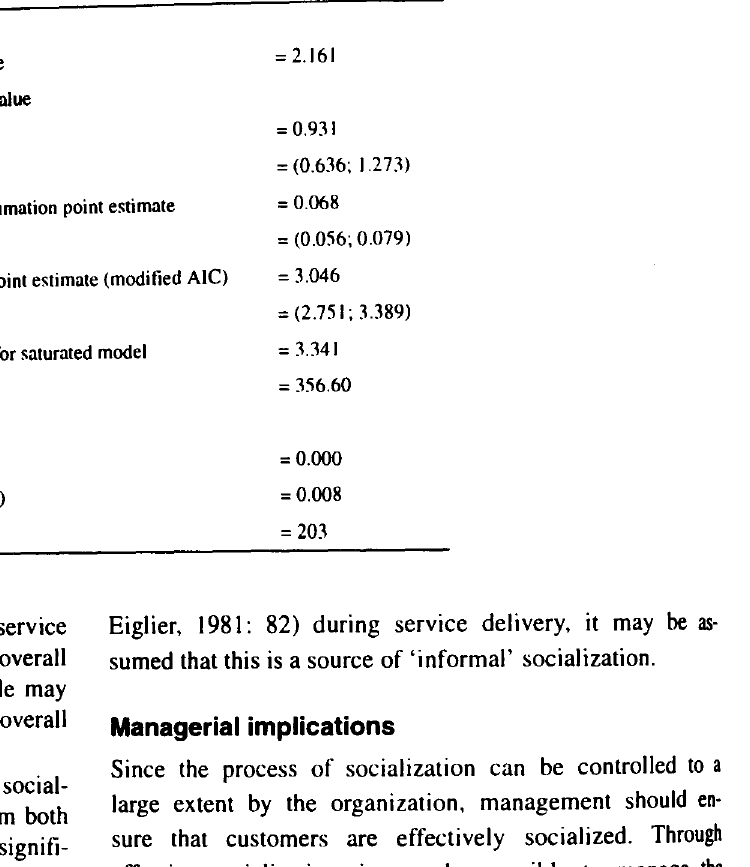
Table 3 Measures of fit of the causal customer